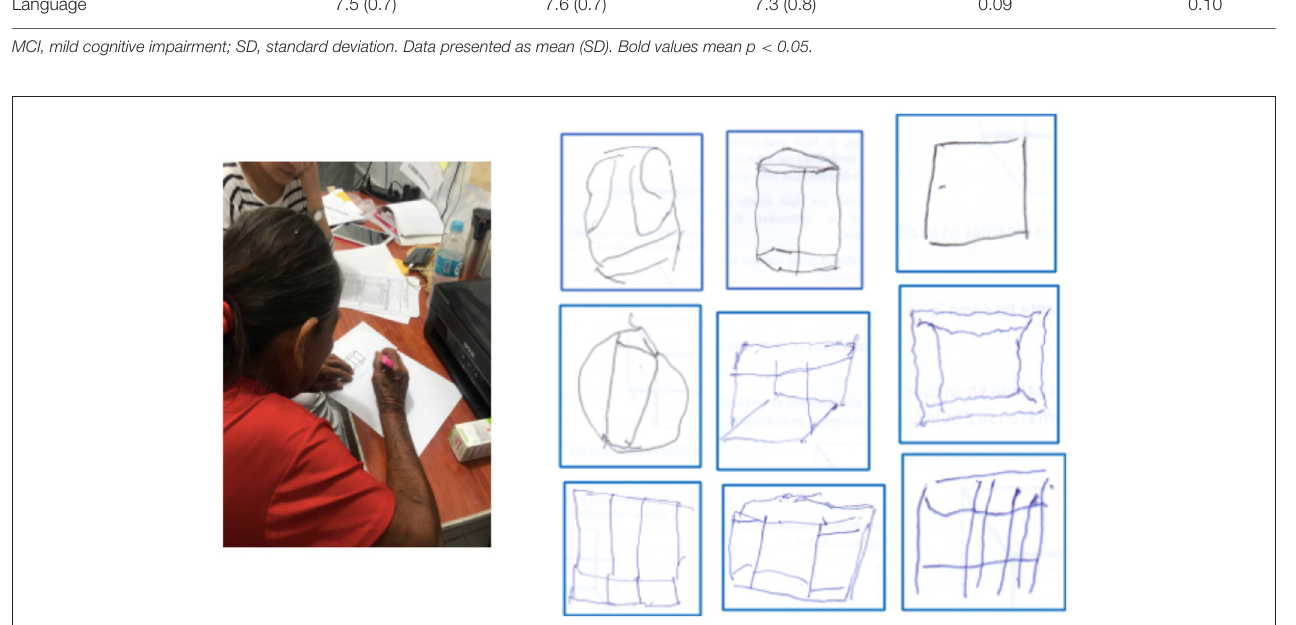
FIGURE 1 | Examples of common errors in drawing the cube in the visuo-spatial construction domain in illiterate individuals from the Santa Clotilde. Note absence of three-dimensionality and distorted